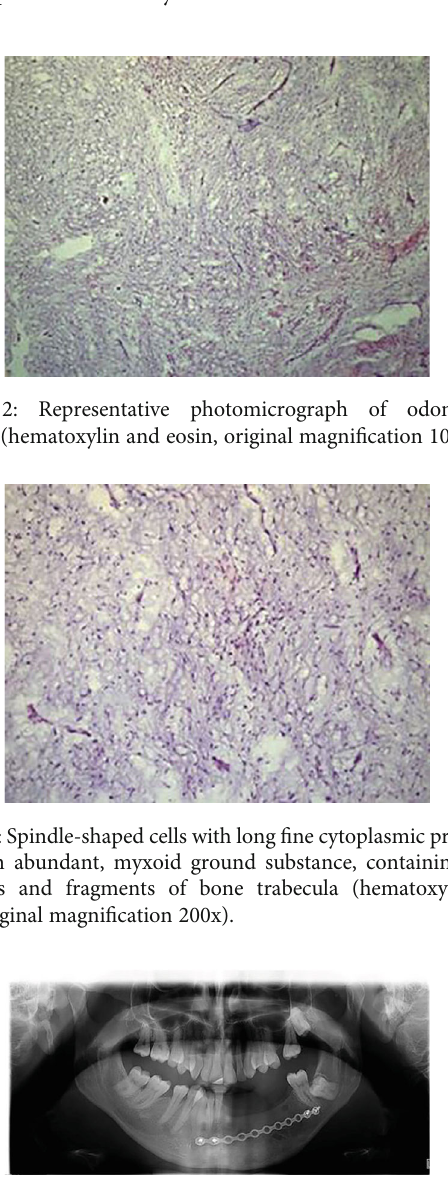
Figure 4: OPG 2 years after resective surgery (2013).